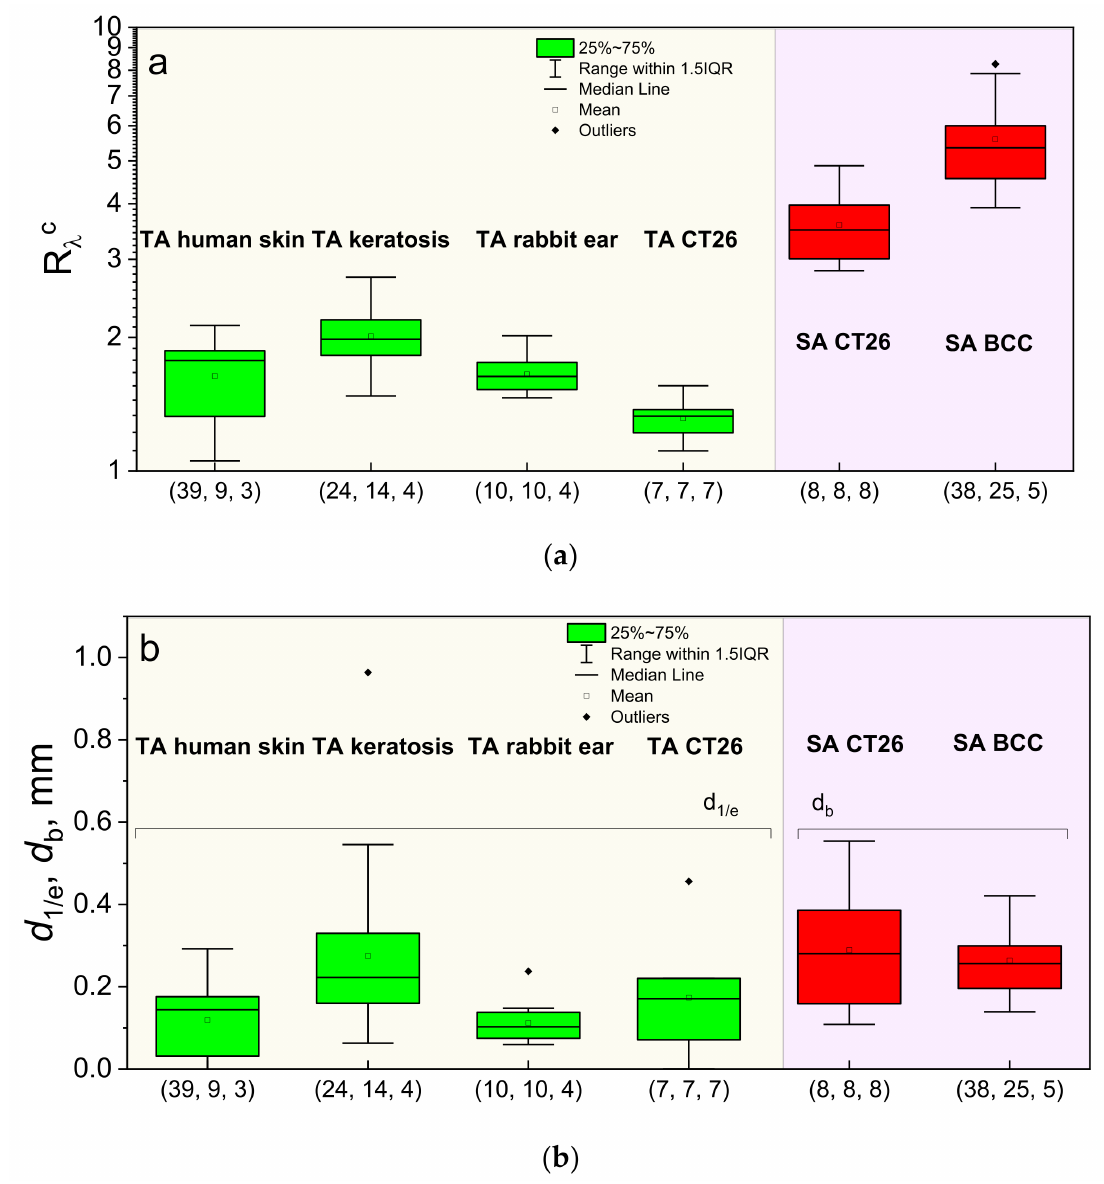
Figure 7. Normalized fluorescence signal ratio values of R λ c detected after the PS accumulation ( a ) and the corresponding PS localization depths ( b ) for topical application (TA) and intravenous injection (SA) in laboratory animals (CT26 tumor model in Balb/c mice, inner surface of the rabbit ear), human volunteers (normal human skin) and in patients (actinic keratosis, BCC). In the brackets, total number of time points, treatment sites and independent species in the group is